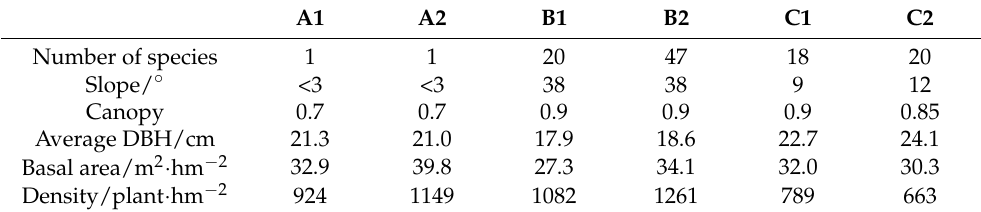
Table 1. Details of the